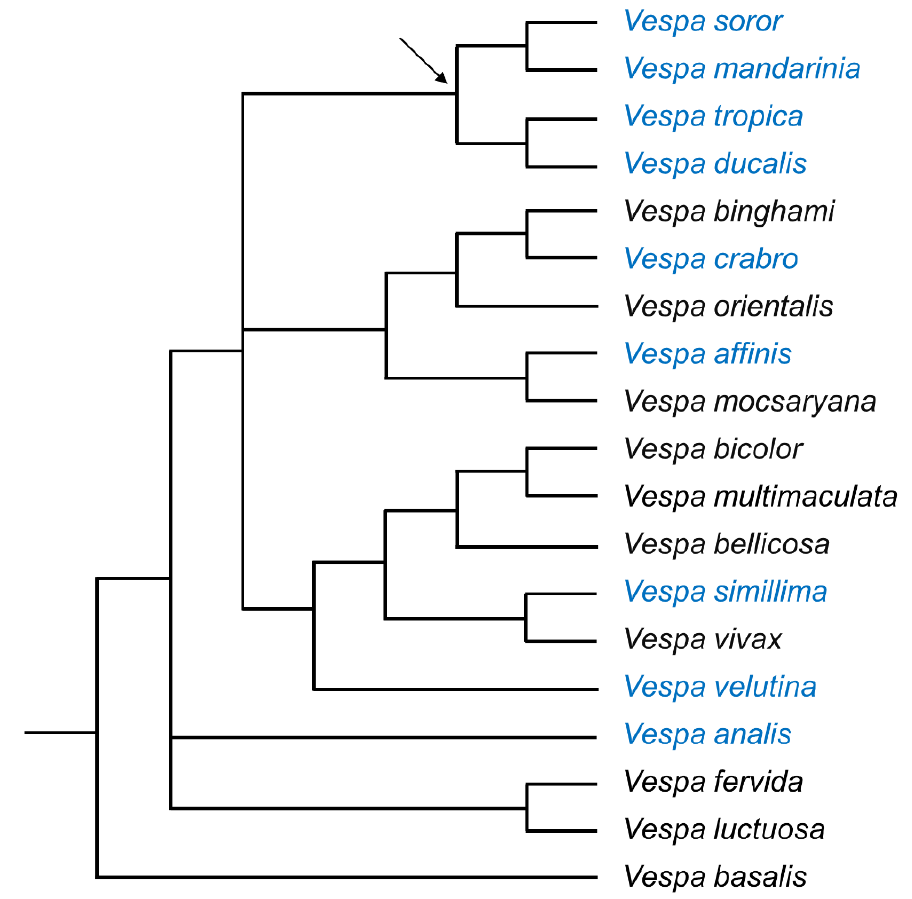
Figure 1. Phylogeny of the genus Vespa (19 of 22 species). Relationships are supported by a combined analysis of morphological characteristics, wing-venation landmarks, and molecular data, modified after Perrard et al.’s Figure 8 [4]. The nine species examined in this study are indicated by blue text; the arrow indicates the root of the ‘ tropica group’